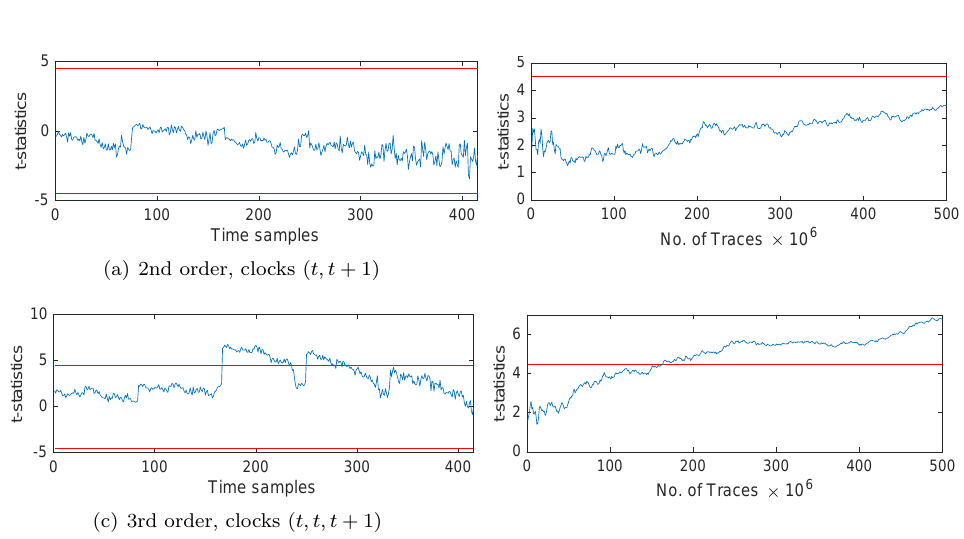
Figure 9: Multivariate non-specific t -test results with 500 million measurements for a single DOM- dep multiplier with d = 3, based on GF (2 4 ) multiplications. registers due to the composition; and the purple registers are optional pipeline registers for the inner-domain terms (which are not considered by the authors of UMA).